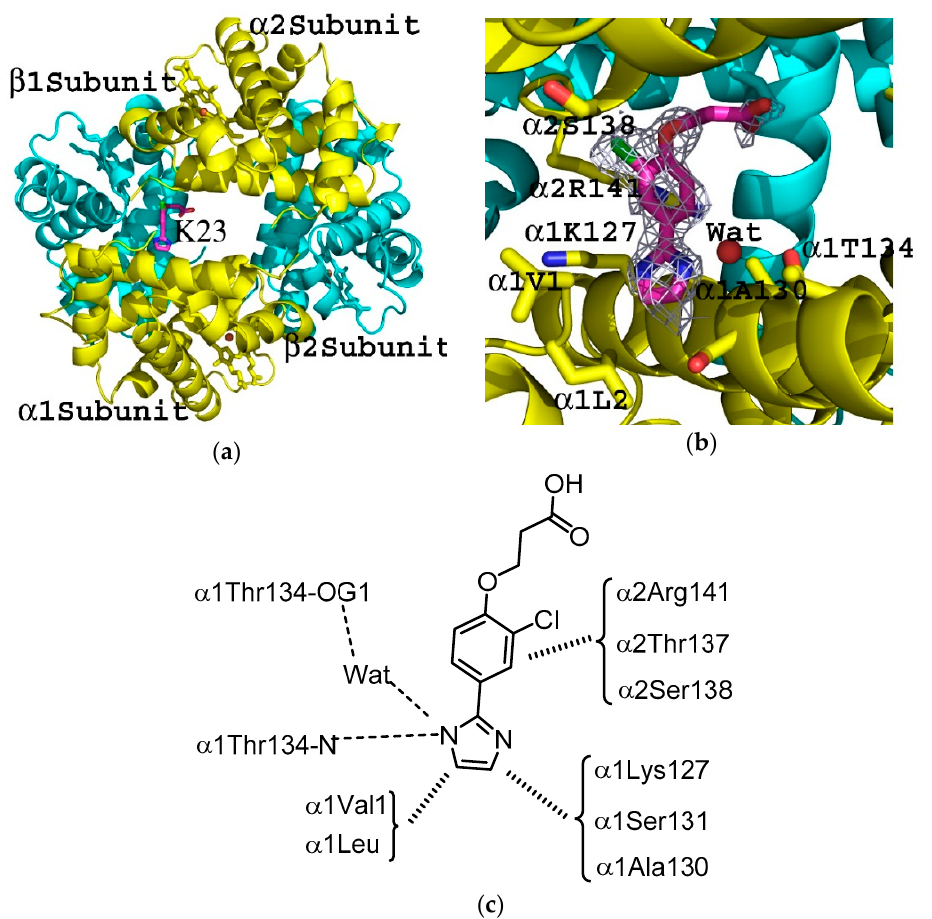
Figure 4. Tetrameric structure of deoxygenated Hb (ribbon) in complex with KAUS-23 (K23; sticks). ( a ) KAUS-23 bound in the central water cavity. Note that only one of the symmetry-related molecules was modelled since the electron density of the second site was too weak and disordered. The α -subunits are colored in yellow and β -subunits in cyan; ( b ) Close-up view of KAUS-23 binding with the final 2Fo-Fc refined electron density map contoured at 0.8 σ . For clarity, not all binding site residues shown but described in the text; ( c ) Schematic representation of the interactions between KAUS-23 and the protein at the central water cavity.